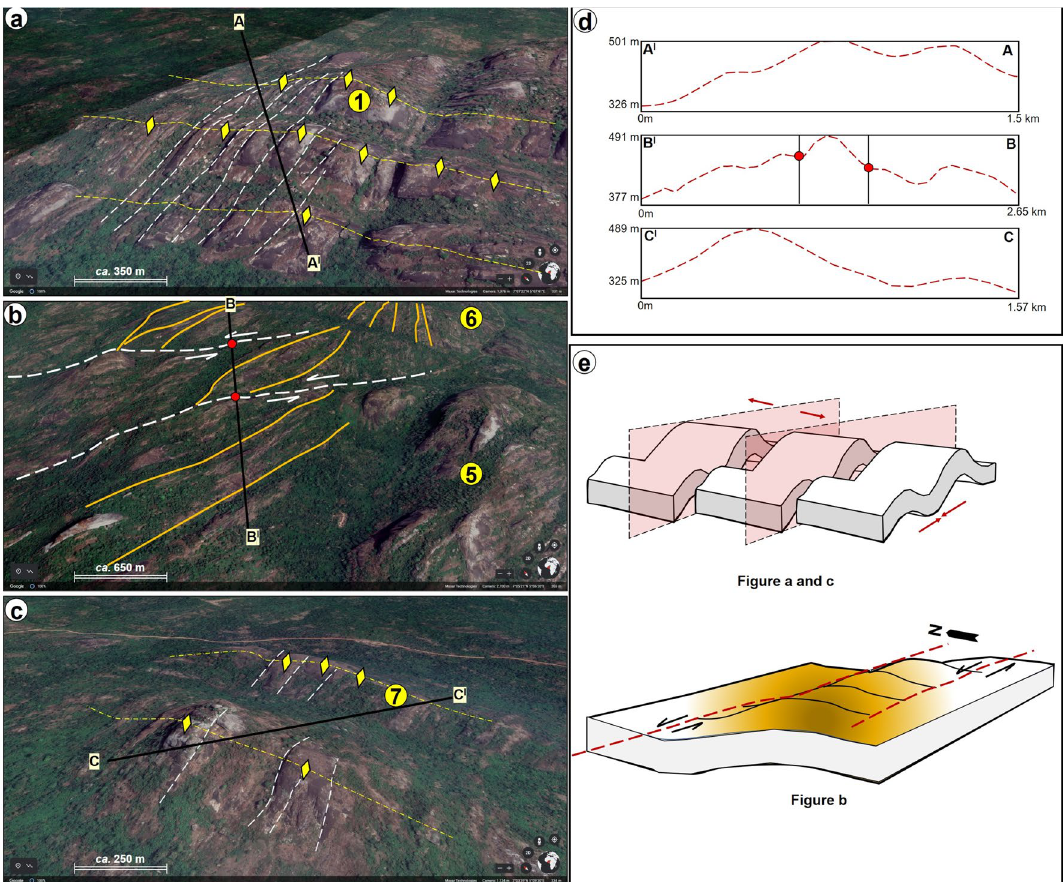
Figure 12. ( a ) Interpretation of structures from some of the selected points ( d ) Transects and topographic profiles the structures indicated in ( a )–( c ) and ( e ) schematic structural model for the interpreted images in ( a )– ( c ). Maps data: Google Earth, Maxar Technologies and